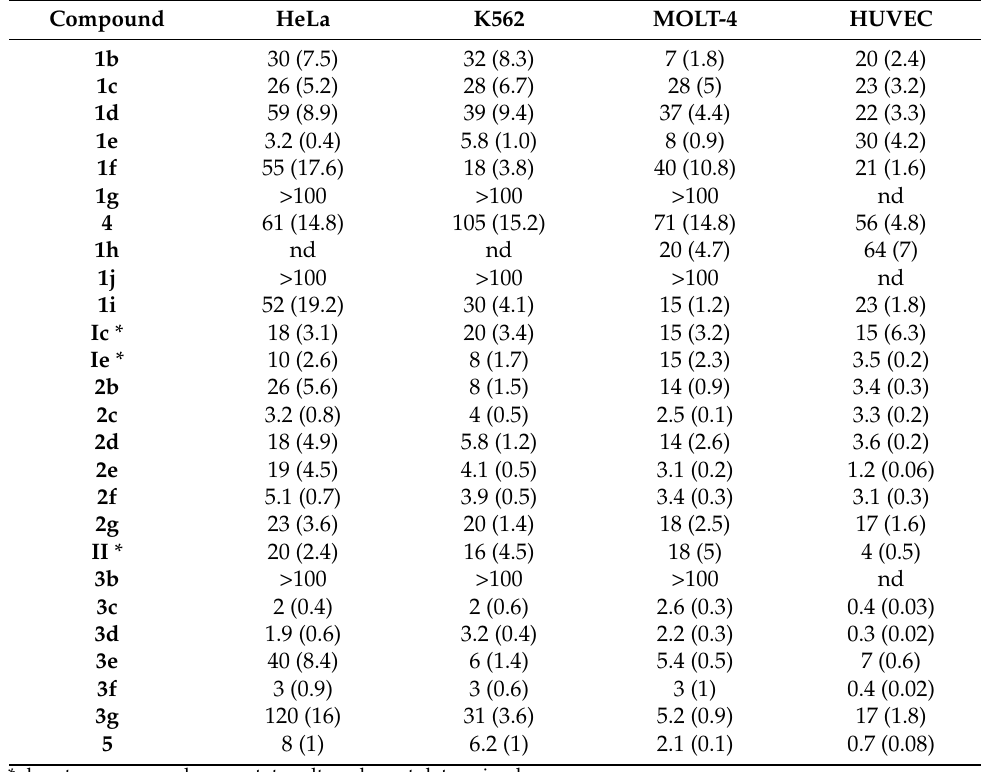
Table 2. The IC 50 values ( µ M) for dicarboximides after 48 h incubation with a given cell line. Average values and standard deviations (in parenthesis) from three experiments are shown. Compounds were used as HCl salts except for Ic *, Ie *, and II * which were used as CH 3 COOH salts.